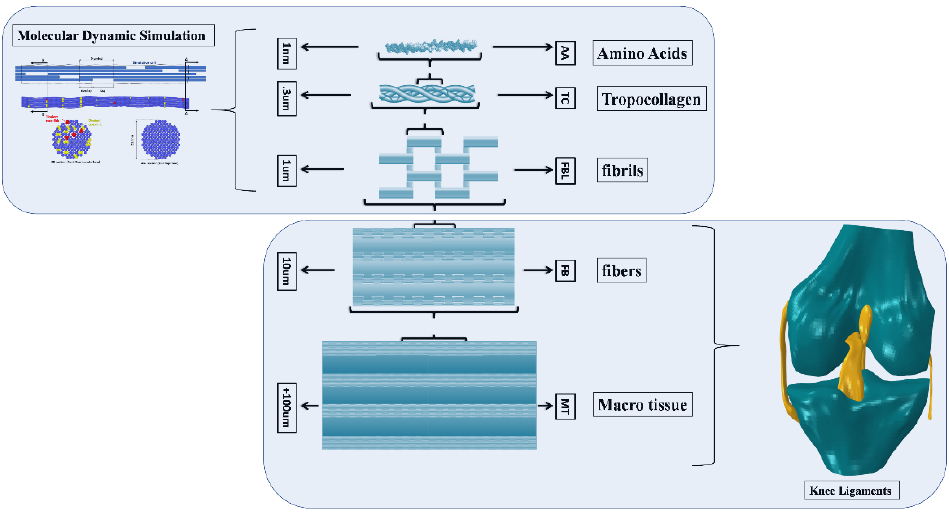
Figure 2. Schematic diagram showing the hierarchical features of the ACL